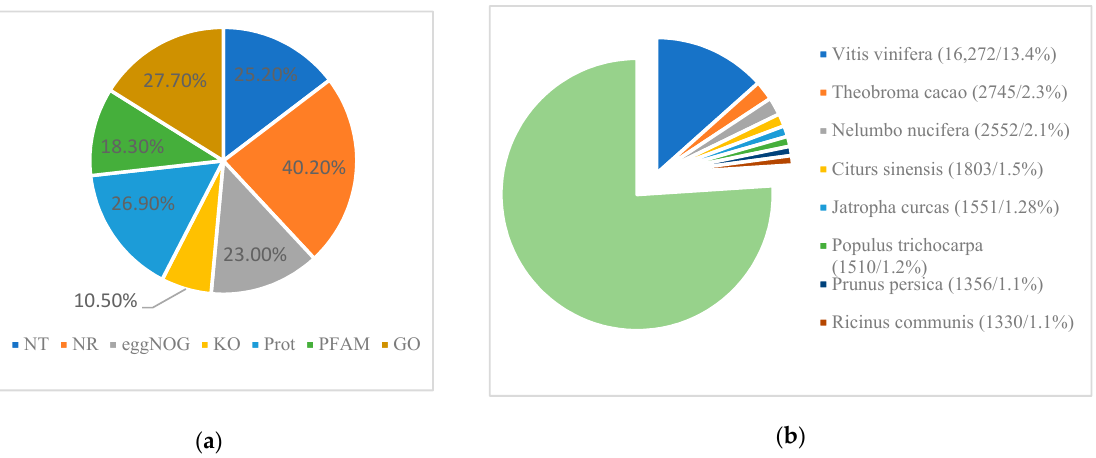
Figure 3. Unigene mapping. ( a ) Different database mapping results; ( b ) species matching based on the Nr database.